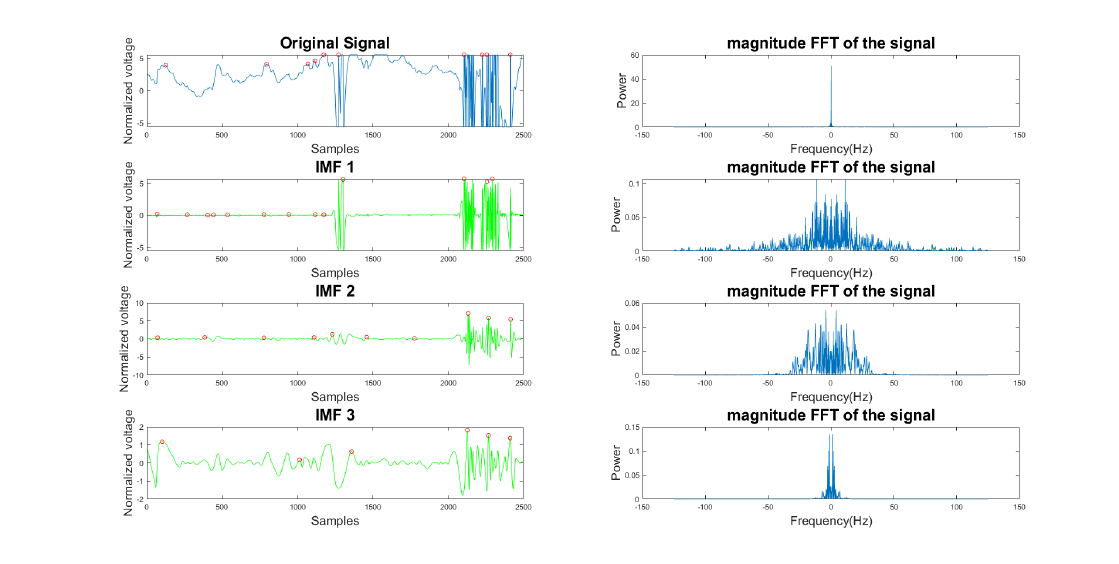
Figure 6. Time and frequency form of an unusable ECG signal and its IMFs.